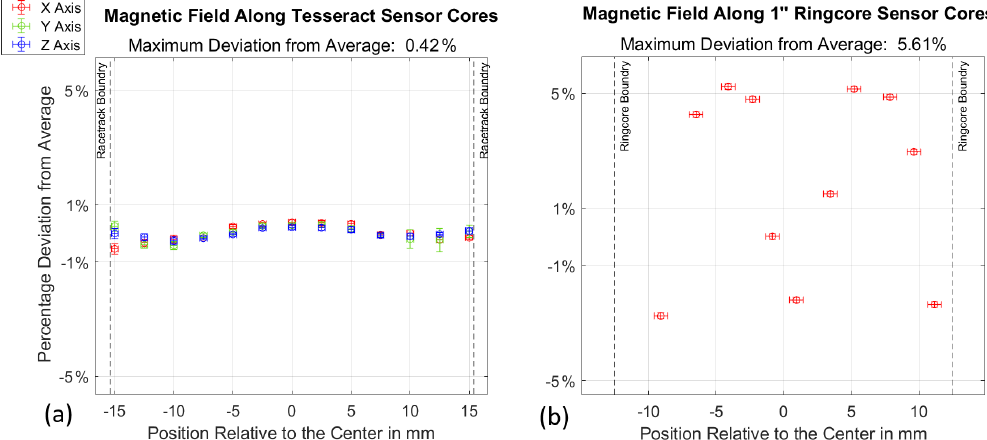
Figure 7. (a) The magnetic field generated by the Tesseract Prototype no. 3 sensors’ feedback windings was measured in 2.5mm intervals along the axis of the racetrack borehole. The magnetic field is plotted as the percentage deviation from the average value in the racetrack core region (between − 15 . 7 and 15.7mm). The feedback magnetic field does not deviate by more than 0.42% along the core axis, and the feedback coils consume 29.7mW to the null earth field. (b) The measured percentage deviation of the magnetic field for each position along the axis of the Miles et al. (2013) ring-core sensor feedback winding. The magnetic field deviates by as much as 5.62% in the domain of the one-inch ring core (between − 12 . 7 and